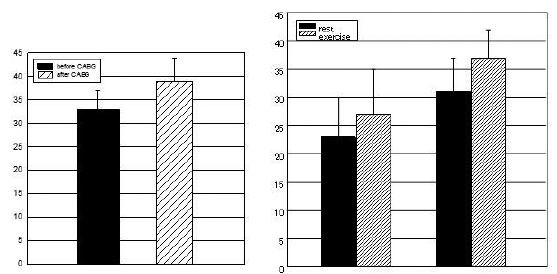
Figure 2 - Evaluation of myocardial function before and after CABG. (a) echocardiography; (b) GATED at